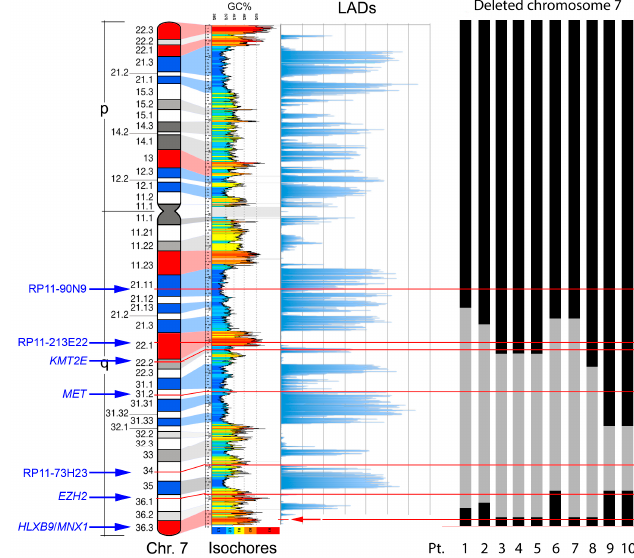
Figure 4. Fluorescence in situ hybridization (FISH) patterns observed in metaphases and nuclei of patients with del(7q). The 7q deletion breakpoints in Pt-1 to Pt-10 were determined by dual-color FISH using different probes, indicated at the bottom of each panel. The HLXB9 gene was detected using the BAC probe RP5-1121A15 (7q36.3). KMT2E (7q22) + MET (7q31.2) and KMT2E + EZH2 (7q36.1) were detected using commercial probe mixtures from MetaSystems. Whole chromosome paint 7, RP11-90N9 (7q21.11), RP11-211E22 (7q22.1), and RP11-73H23 (7q34) are BAC probes previously described (see Materials and methods). Metaphase chromosomes and interphase nuclei were counter-stained in blue with DAPI. Magnification 1000×.